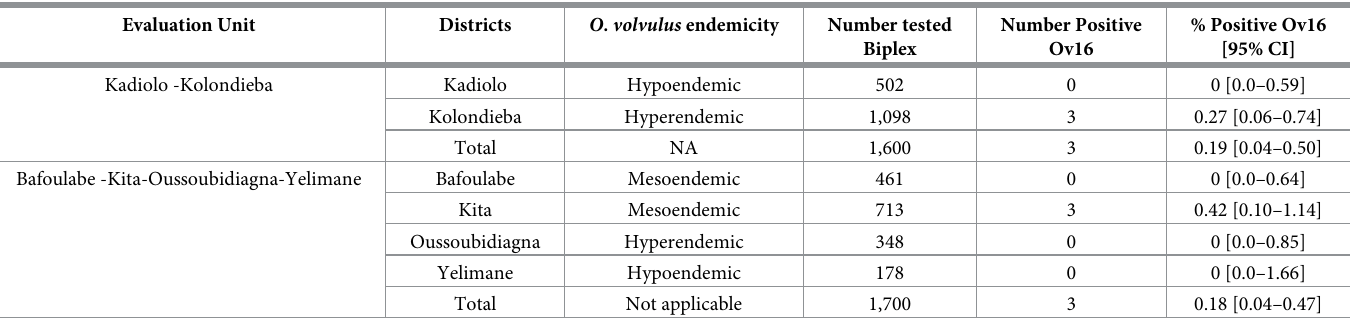
Table 5. Onchocerca volvulus seroprevalence per district and evaluation unit according to pre-control endemicity. Evaluation